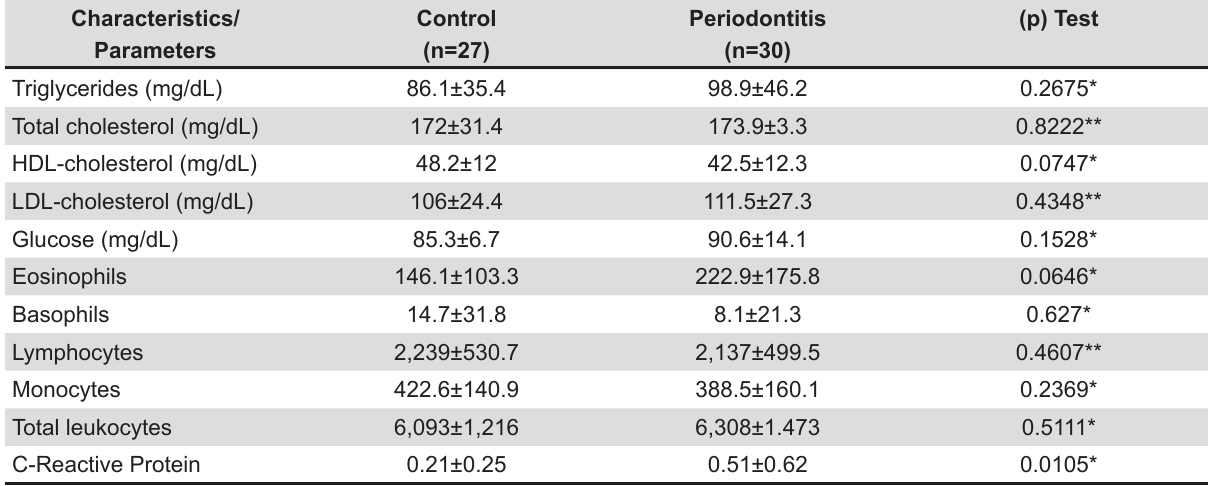
Table 2- Biochemical and hematological characteristics